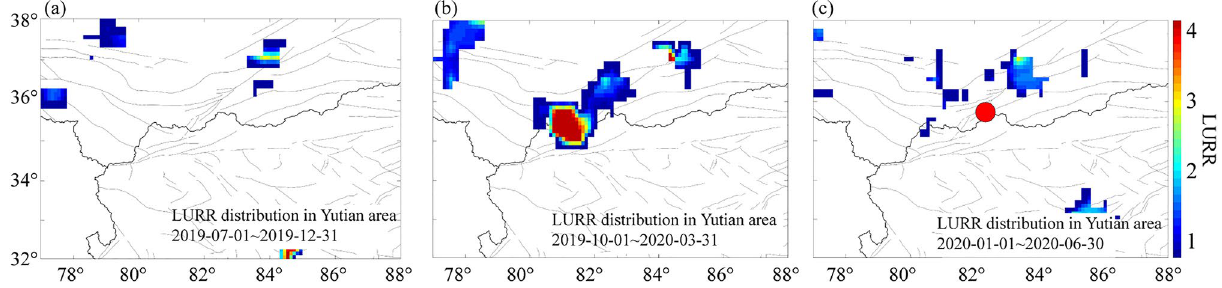
Figure 6. Spatial distribution of LURR anomalies in Xinjiang before the Yutian earthquake. The calculated time window is shown in each of the maps, and the LURR value is given by the color code, and the red dot in ( c ) is the Yutian earthquake. The three figures were created by using the Matlab R2016b (https:// www. mathw orks. com/ produ cts/ matlab. html, accessed on 27 September 2022).